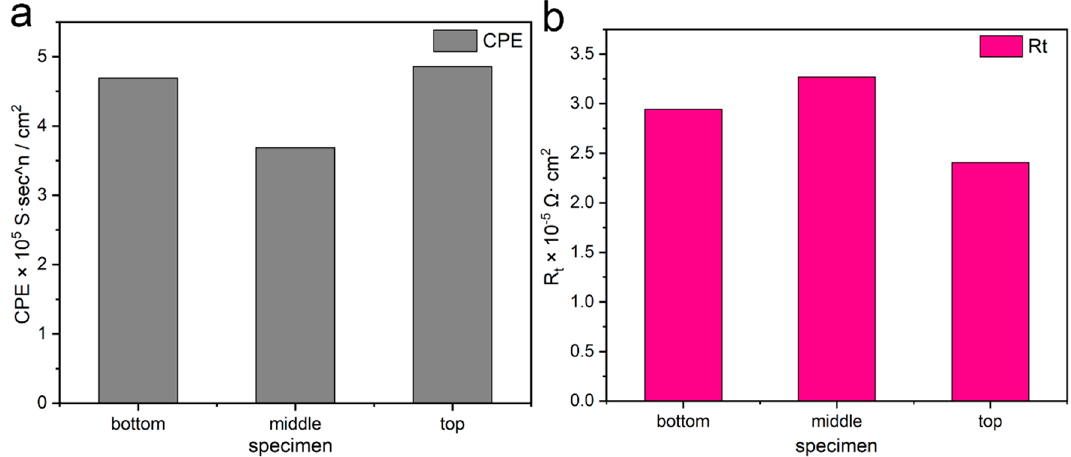
Figure 17. Electrochemical impedance test data of the bottom, middle, and top region specimens of the wire arc additive manufacturing (WAAM) 316L as-deposited sample: ( a ) Nyquist plots and ( b ) equivalent circuit model (EEC).